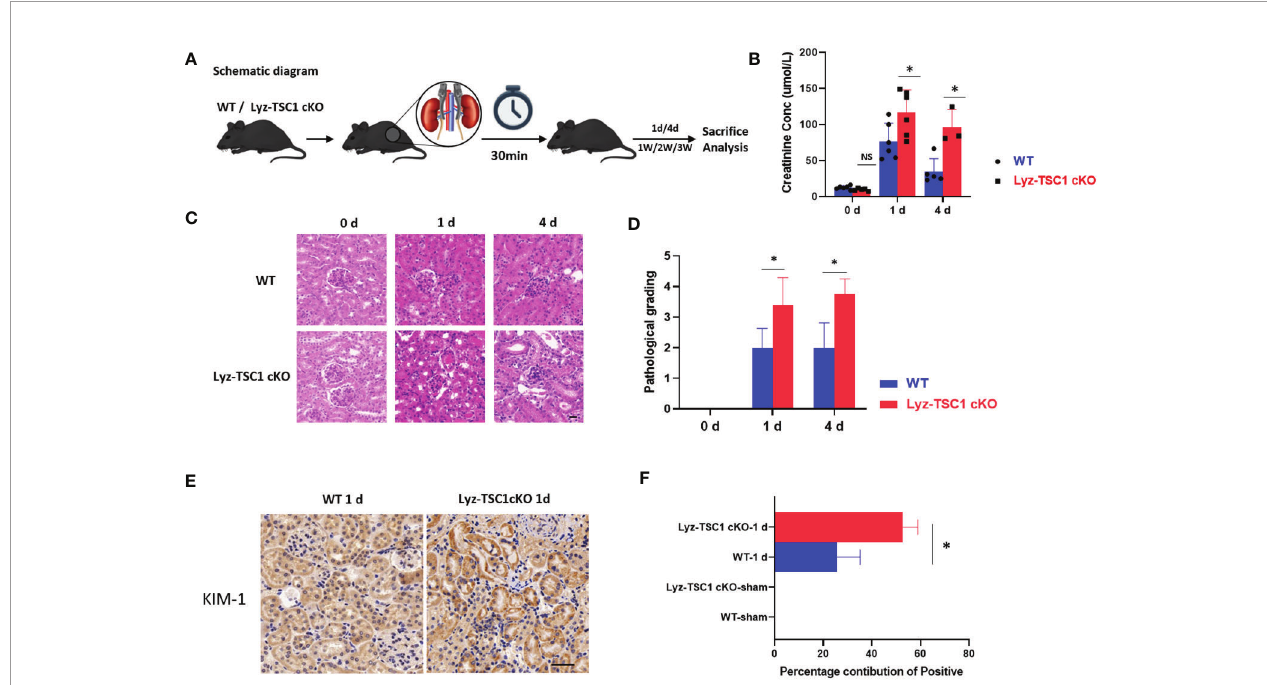
FIGURE 1 | TSC1 depletion in macrophage aggravated mice IR-induced tubular injury. (A) Schematic diagram. (B) Serum creatinine levels in wild-type (WT) and Lyz-TSC1 cKO mice at baseline (0) and 1 and 4 days post-IRI. (C) Representative H&E-stained renal sections of WT and Lyz-TSC1 cKO mice. Scale bar: 20 µm. (D) Quanti fi cation of H&E staining corresponding to the WT and Lyz-TSC1 cKO mice shown in (C) . (E) Representative Kidney Injury Molecule 1 (KIM-1) immunohistochemistry in renal sections from WT and KO mice on day 1 post-IRI (×200). (F) Quanti fi cation of KIM-1 immunohistochemistry-stained murine renal cortical sections on day 0 and day 1 after IRI. In (B , D , F) , the data are shown as the mean ± SD and were analyzed by an unpaired two-tailed Student ’ s t-test (n ≥ 3). *P < 0.05; **P < 0.01; NS, not signi fi